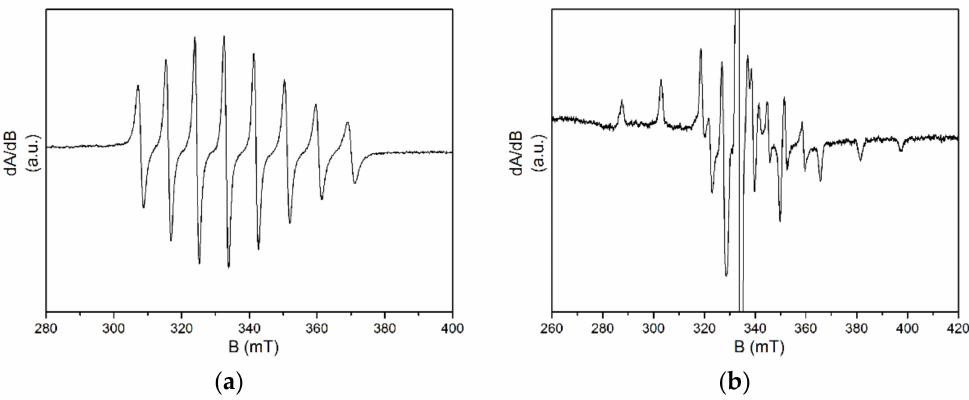
Figure 3. EPR spectra of VO ( a ) in CH 2 Cl 2 solution and ( b ) in frozen 1:1 mixture of CH 2 Cl 2 /ethanol.